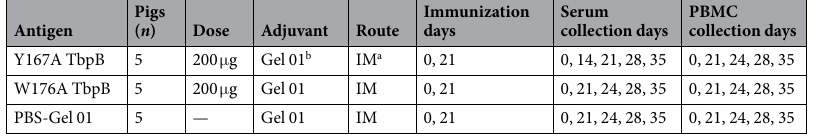
Table 1. Experimental design of animal immunization. a Intramuscular; b Montanide Gel 01 (final concentration of 20%).